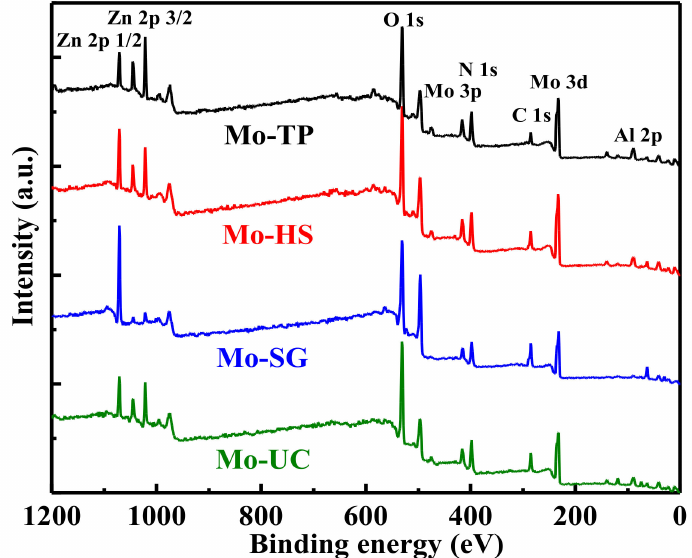
Figure 5. The X-ray photoelectron spectroscopy (XPS) survey spectra of the Mo/ZnAl-LDH